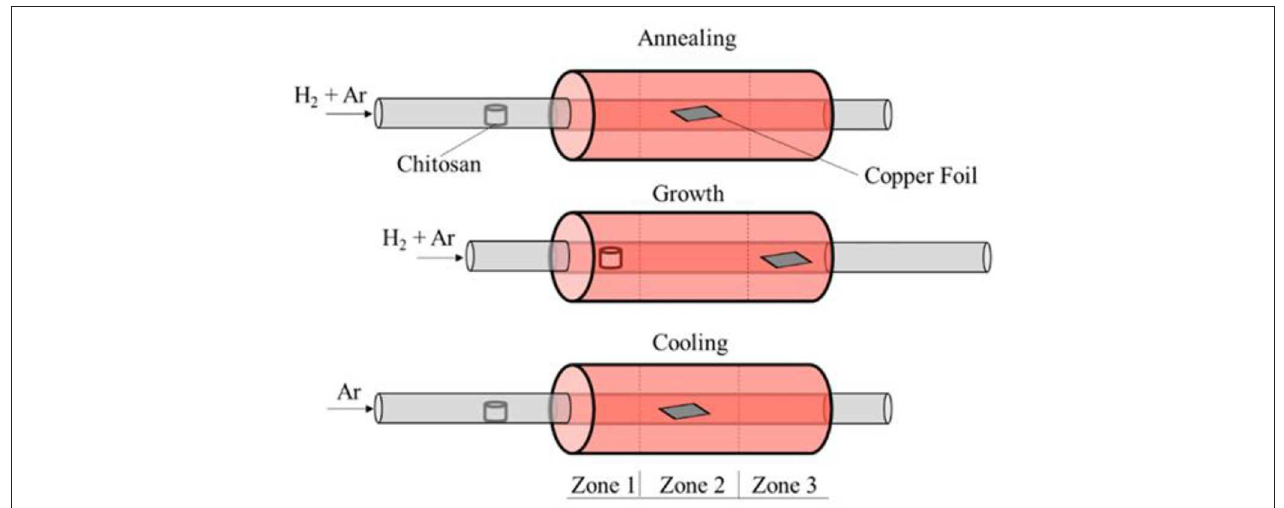
FIGURE 8 | Schematic representation of the N-GQD fabrication via chemical vapor deposition (CVD) process; reproduced from Kumar et al. (2018) with permission from the American Chemical